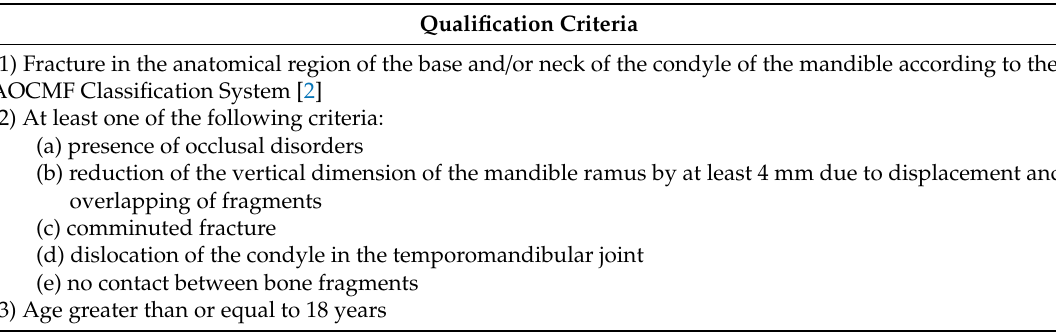
Table 1. Criteria for including patients in the